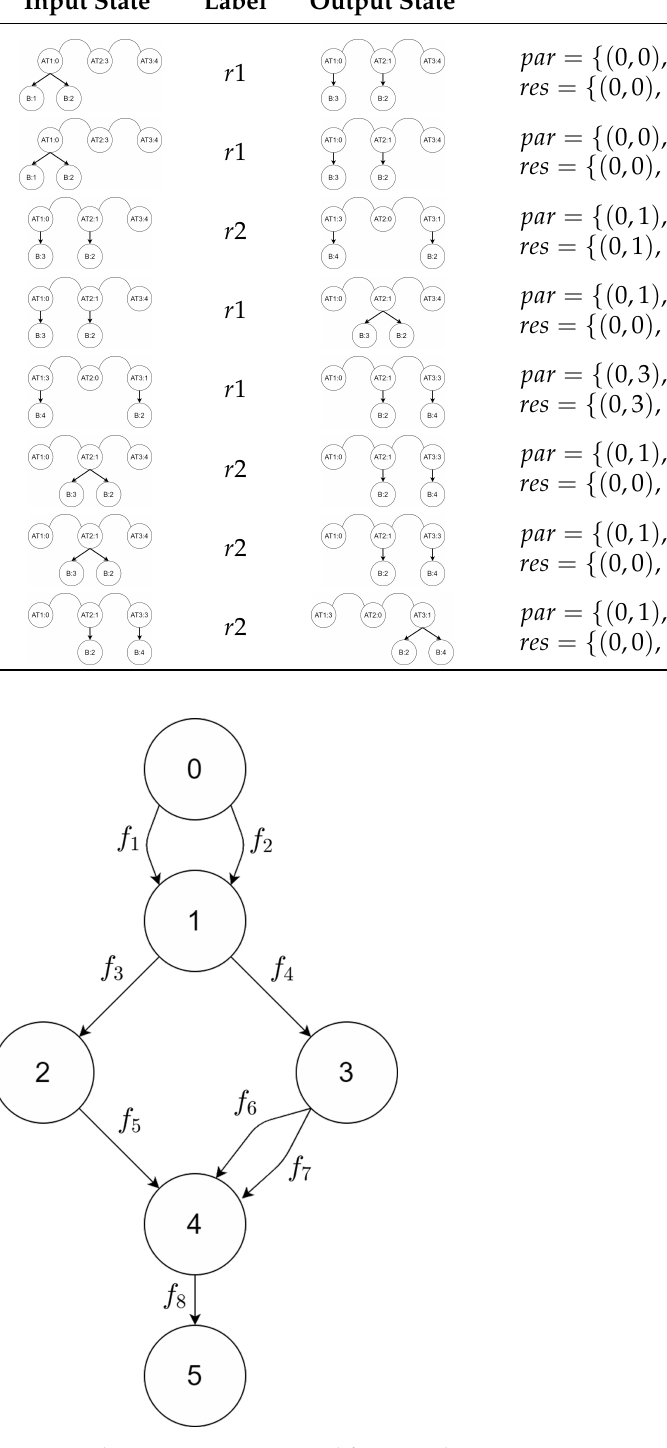
Figure 9. The state space generated from Tracking Transition System from Table